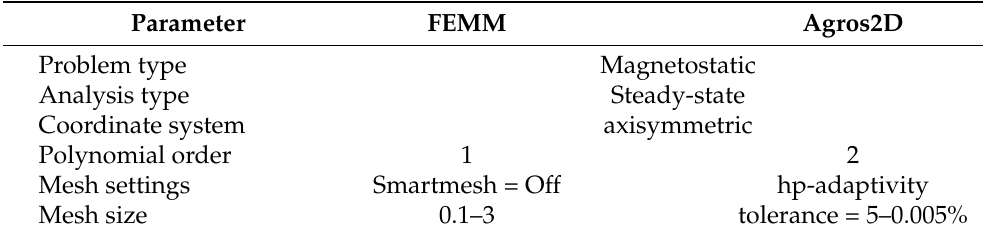
Table 2. The settings applied for the FEMM- and Agros2d-based